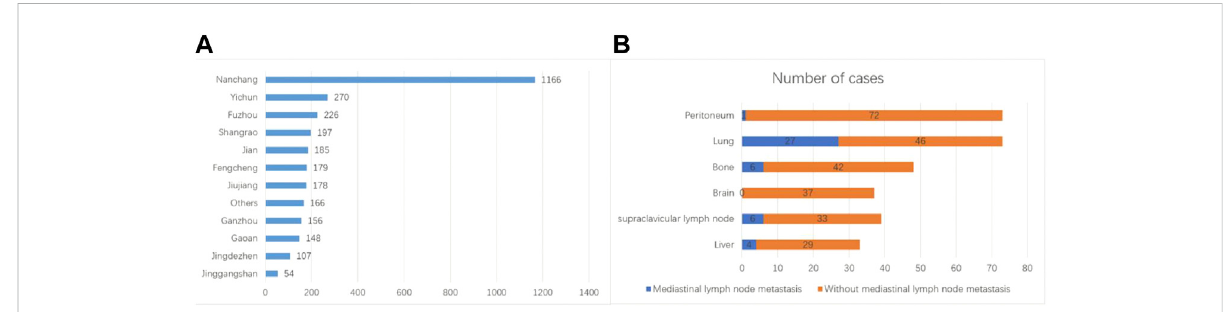
FIGURE 1 Clinical features of the patients. (A) Geographic location of the patients. (B) Anatomical locations of metastasis and corresponding